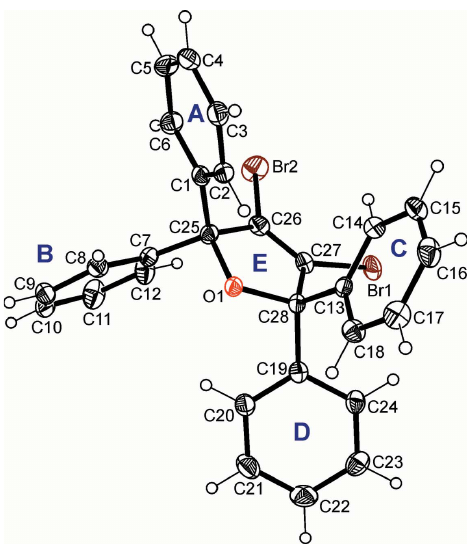
Figure 1 Perspective view of the title compound including atom labelling and ring specification. Non-hydrogen atoms are shown with 50% probability displacement